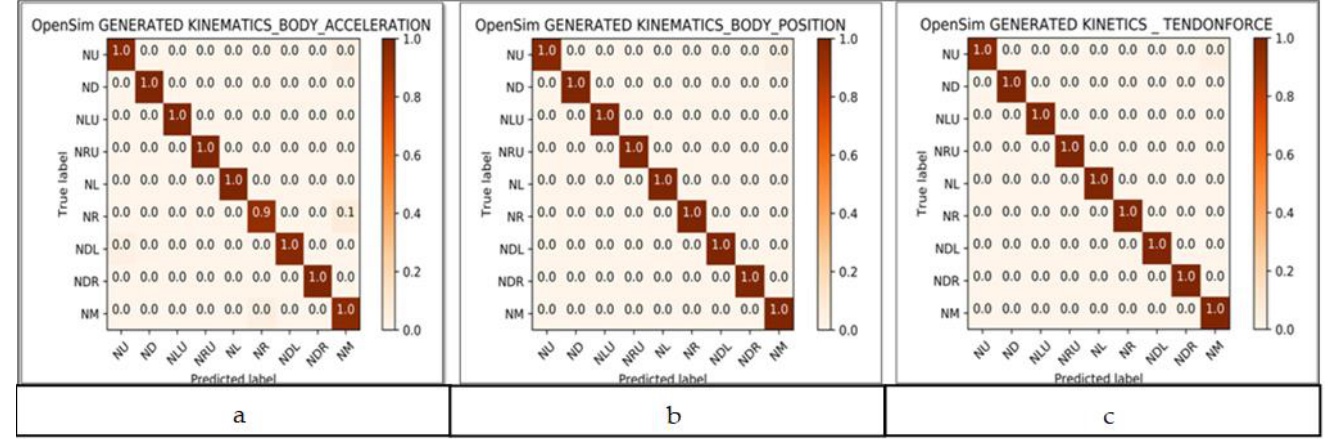
Figure 9 . ( a ) Kinematics — neck acceleration; ( b ) kinematics — neck position; ( c ) kinetics — tendon forces. Figure 9. ( a ) Kinematics—neck acceleration; ( b ) kinematics—neck position; ( c ) kinetics—tendon